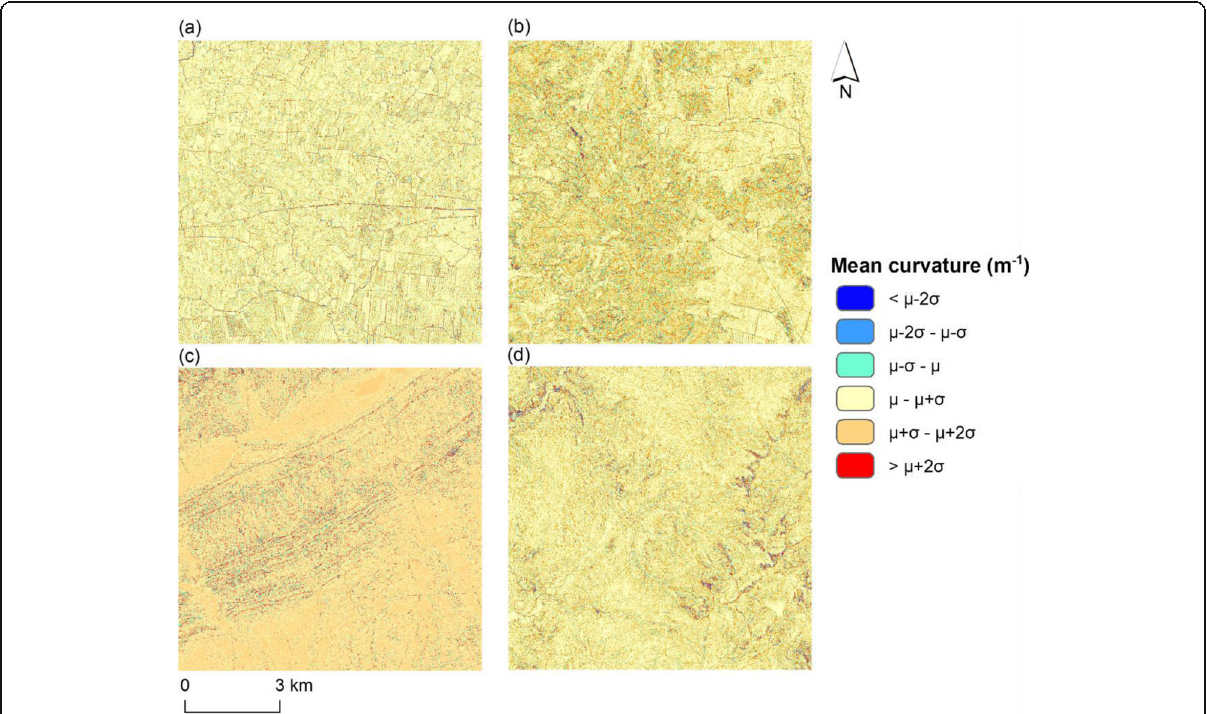
Fig. 6 Mean curvature maps for the four study areas: a floodplain, b plain to hilly, c hilly, d mountain. Mean curvature is colour-coded according to 1 to 2 times intervals of standard deviation σ from the mean